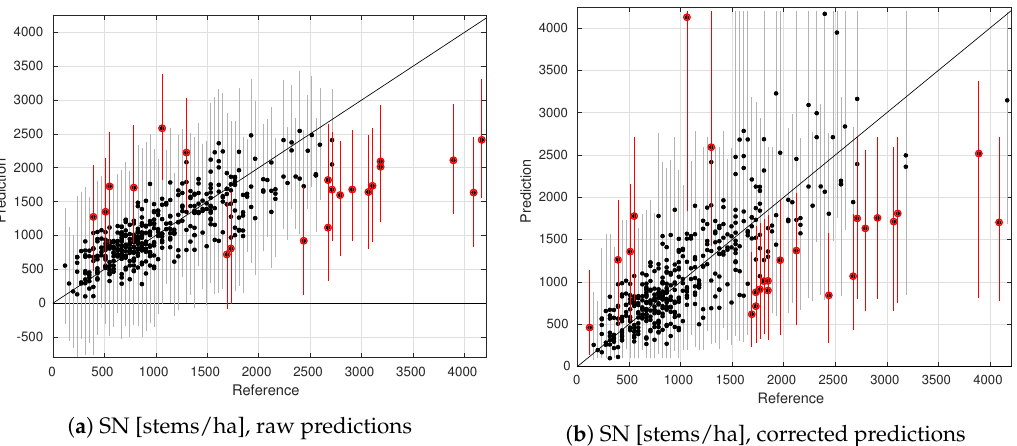
Figure 8. Stem number: Raw predictions, 8a, and corrected predictions, 8b with their 95% probability intervals (gray lines). The predictions for which the truth is outside the given 95% probability interval are shown with red